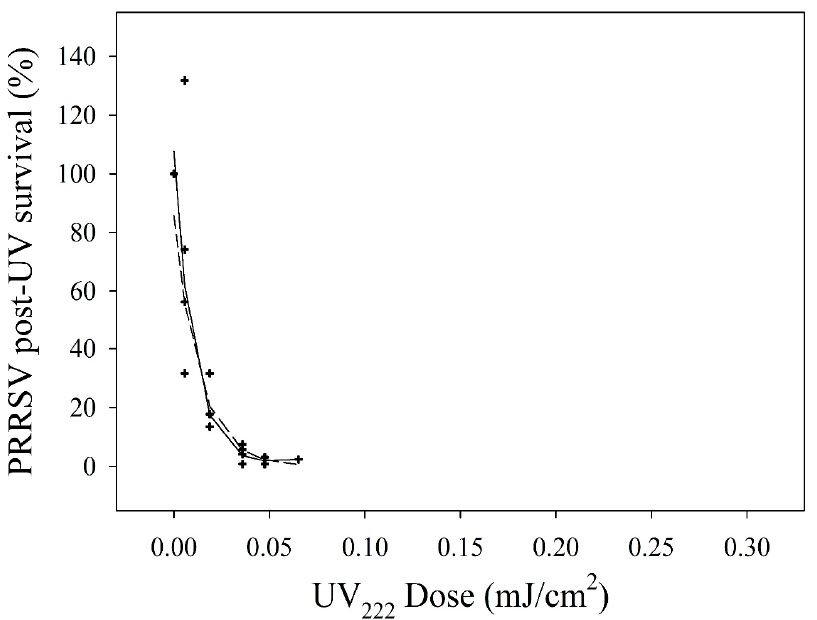
Figure 3. UV ‐ C (222 nm) treatment inactivation of aerosolized PRRSV. PRRSV post ‐ UV survival (%) = N t /N 0 . A log 10 normalized PRRSV post ‐ UV survival is shown in Figure A2. One ‐ stage and two ‐ stage inactivation models are marked with dashed and solid lines, respectively.